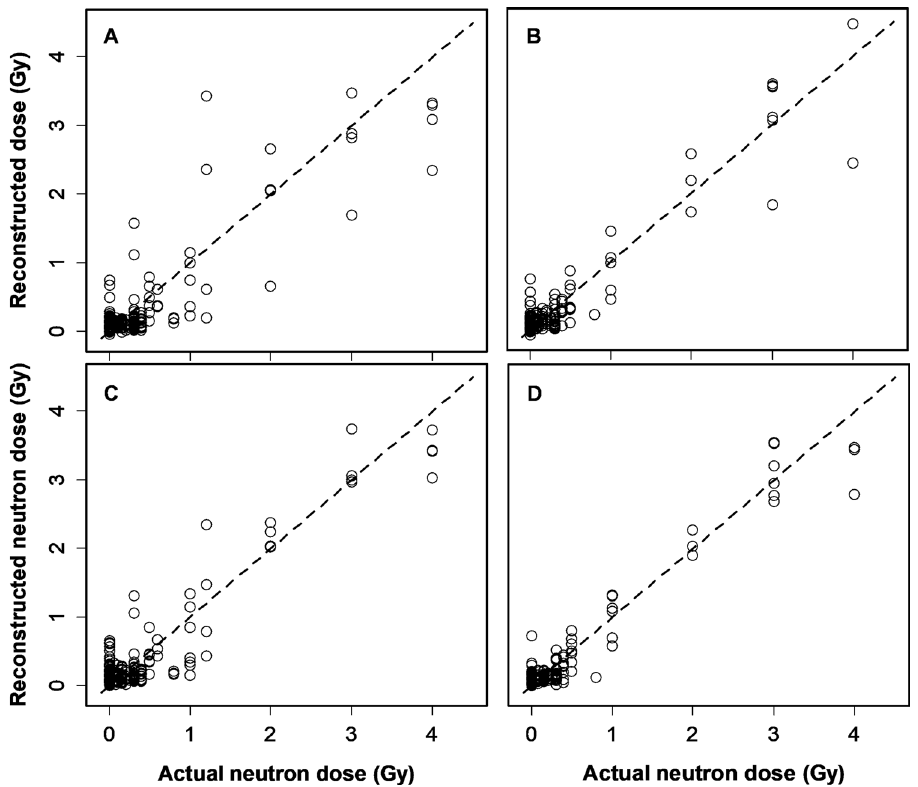
Figure 5. Neutron dose reconstruction results by the robust linear regression (RL) and random forest (RF) algorithms on testing data. ( A ) Results of analyzing the full data set by RL. R 2 = 0.767, RMSE = 0.319 Gy. ( B ) Results of analyzing a subset of data where only blood samples with ≥ 300 cells were used by RL. R 2 = 0.900, RMSE = 0.246 Gy. ( C ) Results of analyzing the full data set by RF. R 2 = 0.860, RMSE = 0.248 Gy. ( D ) Results of analyzing a subset of data where only blood samples with ≥ 300 cells were used by RF. R 2 = 0.936, RMSE = 0.189 Gy. In all panels, circles represent data points (blood samples), and the line represents theoretically perfect 1:1 correlation.